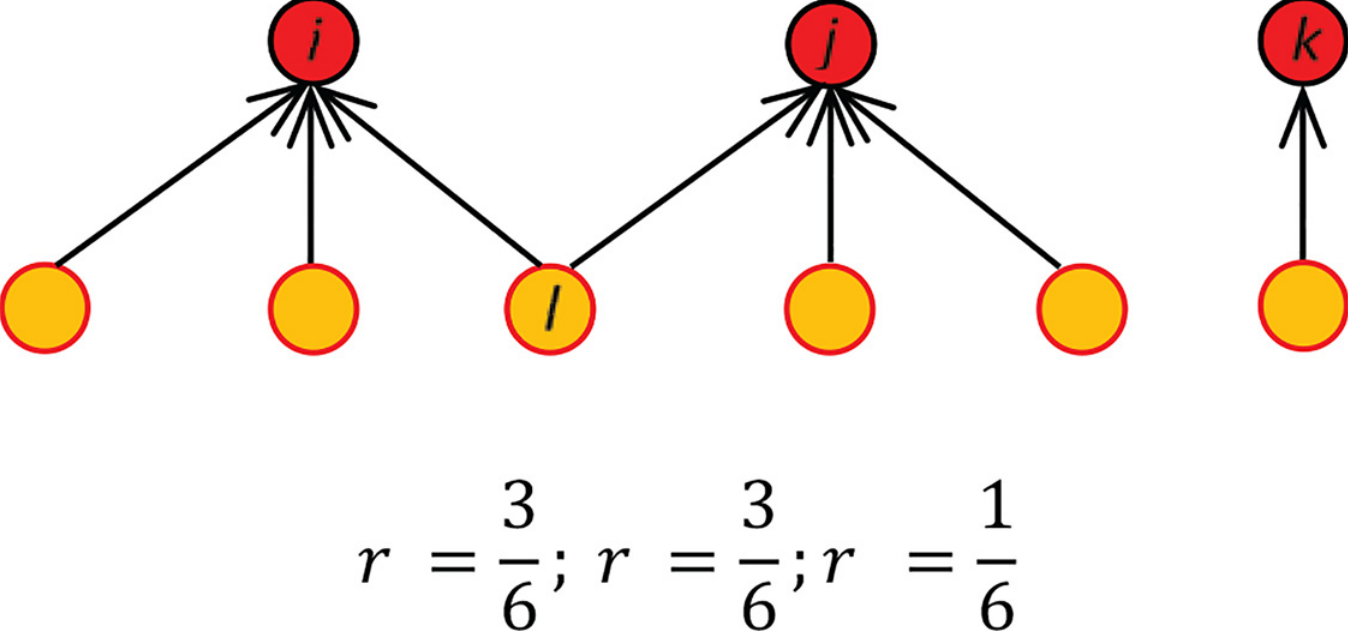
Fig 1. Reach measured as a fraction of all followers. In this schematic representation, there are three protest participants that accumulate six unique followers. The relative reach of each participiant (nodes in red) is the fraction of their direct followers over the total available in the system (nodes in orange). We normalize these counts to fall in the interval [0,1] for the three